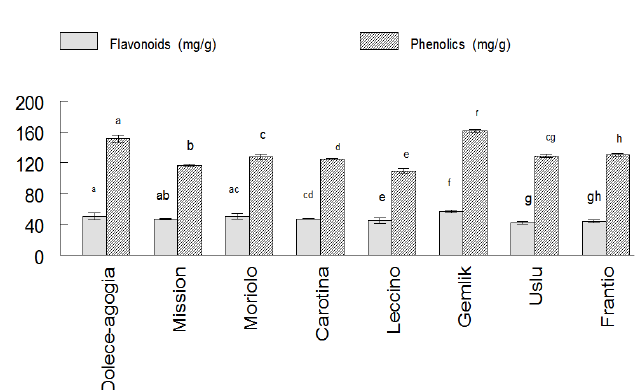
Fig. 3: Total phenolic and flavonoid contents among different cultivars of olive. Values in figure followed by different letter are significantly (P < 0.05) different from control by DMR test. Results are means ± SD (n=3). 3.68 to 161 ± 1.9 mg/g. Gemlik cultivar which showed the highest antioxidant activity showed the highest phenolic content. while, leccino contained the lowest amount of phenolics (Fig. 3). The flavonoid content was found between 42 ± 1.97 to 57 mg/g. Gemlik contained the highest amount of flavonoid. Whereas, Uslu contained the least amount of flavonoid (Fig. 3).